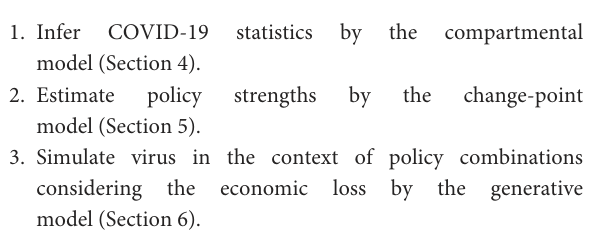
10.3389/fpubh.2022.953472